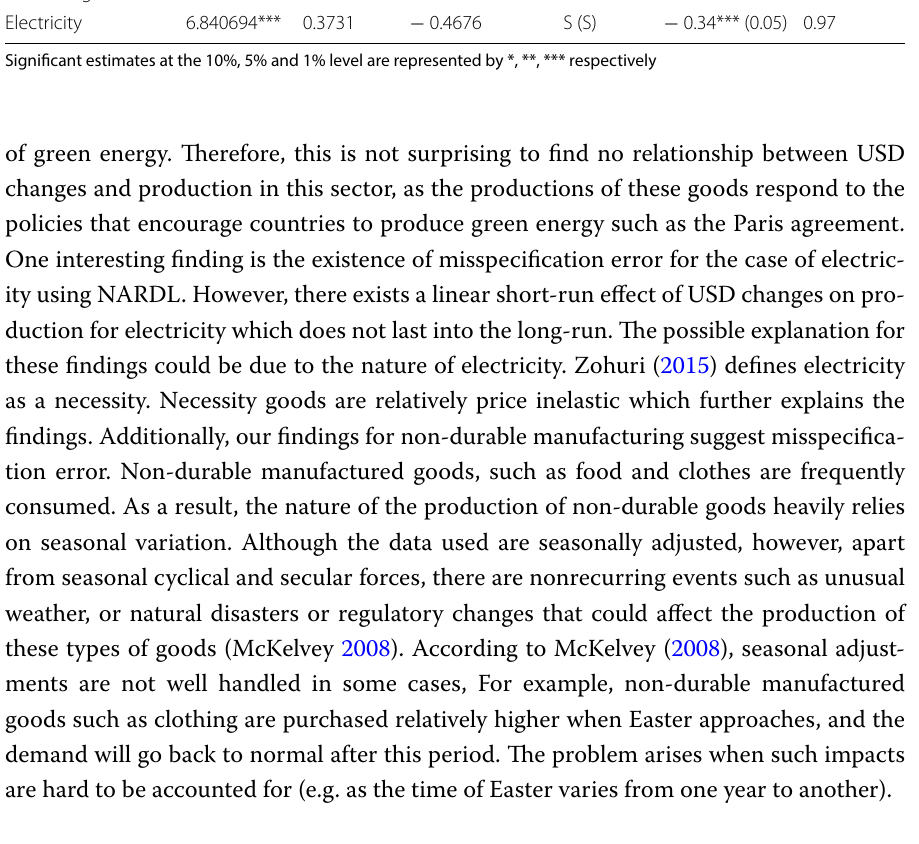
Significant estimates at the 10%, 5% and 1% level are represented by *, **, ***